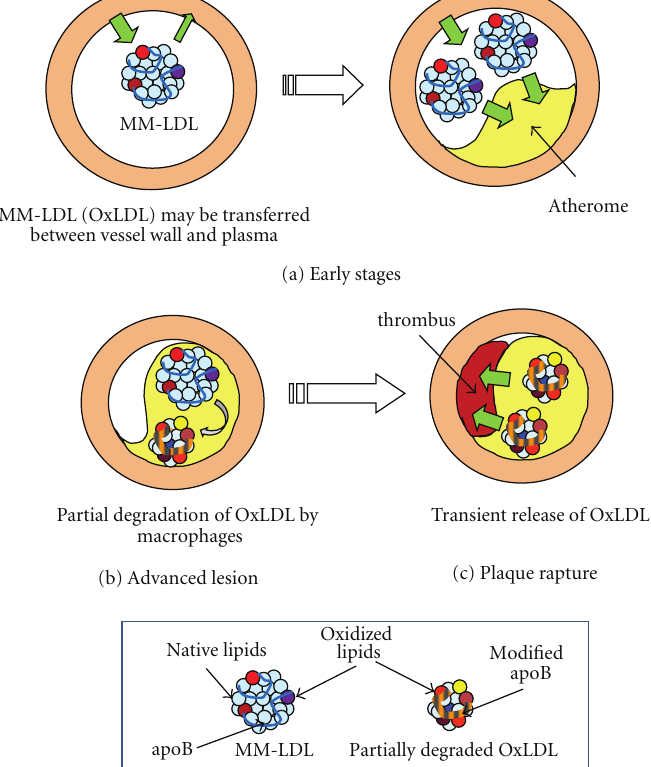
Figure 2: Possible in vivo behavior of OxLDL. (a) The temporal rise and fall of plasma OxLDL levels suggest that MM-LDL (OxLDL) may be transferred between the vessel wall tissues and circulation in the early stages of atherogenesis. In this stage, circulating OxLDL is likely to be MM-LDL, since heavily oxidized LDL is very rapidly cleared from the circulation. The tissues of the vessel wall could be the site of LDL oxidation, but further study is needed to examine whether oxidation proceeds in apparently healthy vessel walls during the very early stages. When the plasma OxLDL level decreases atherosclerotic lesions appear to develop. (b) In advanced stages, many macrophages and foam cells are found in the atherosclerotic lesions. MM-LDL could be further modified to form OxLDL in the lesions. OxLDL is taken up by macrophages, and processed in the lysosomes. Some of the OxLDL is completely degraded, and a part of OxLDL is relatively resistant to proteolytic processing. Partially degraded OxLDL particles are observed in the lesions. (c) Upon plaque rupture, or when an atherosclerotic plaque is injured by PTCA treatment, OxLDL and partially degraded OxLDL are rapidly released from the lesions into the circulation, which causes a temporal rise of the plasma OxLDL